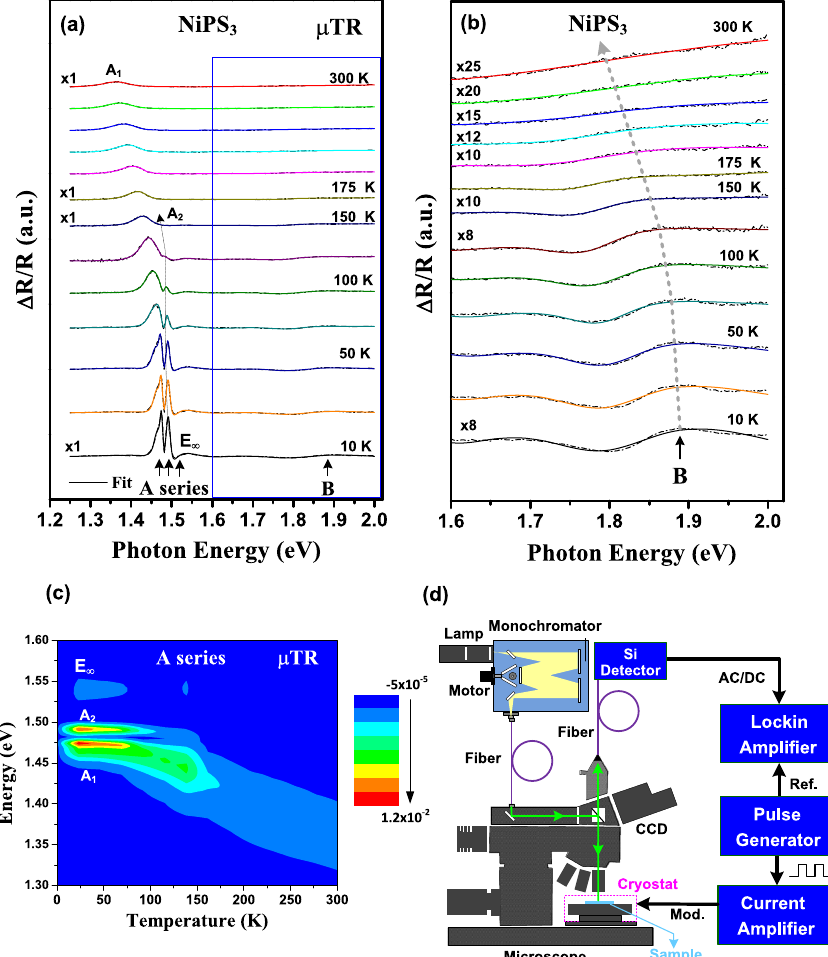
Fig. 2 Temperature-dependent μ TR spectra of NiPS 3 near band edge. a Temperature dependence of the band-edge excitonic transitions of the A series and B observed in few-layer NiPS 3 via μ TR measurements. The solid lines are the least-square fi ts of the experimental data to a derivative of the Lorentzian line-shape function in Eq. (1). b Magni fi cation of the B transition feature in a . c 2D contour plot of the μ TR spectra of the A series excitons from 10 to 300 K to illustrate the temperature-energy shift and intensity change. d Representative scheme of the experimental setup for the temperature-dependent μ TR